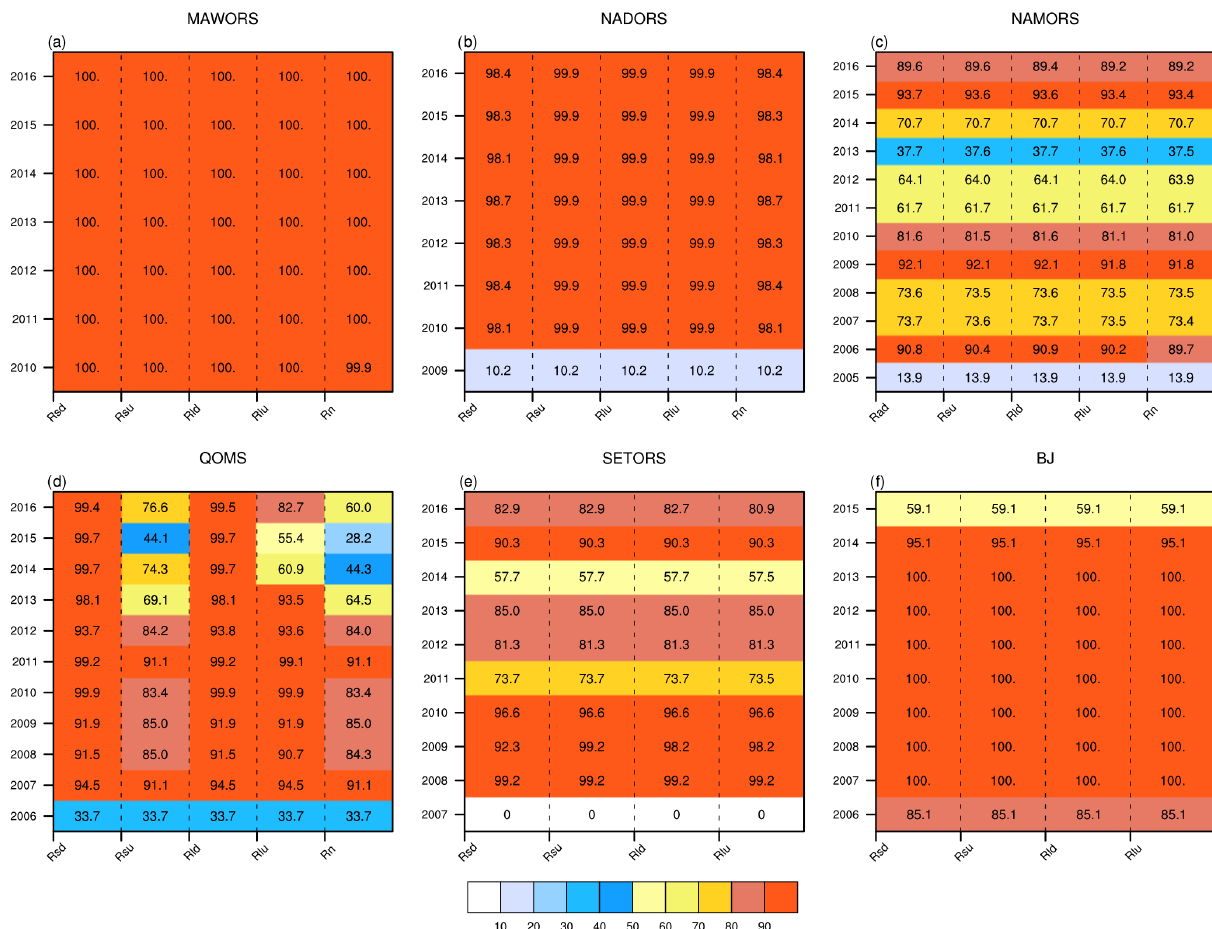
Figure A2. Same as Fig. A1, but for the surface radiations. Rsd and Rsu represent the incoming and outcoming solar radiation, respectively; Rld and Rlu refer to the downward and upward longwave radiation. The net radiation is expressed using